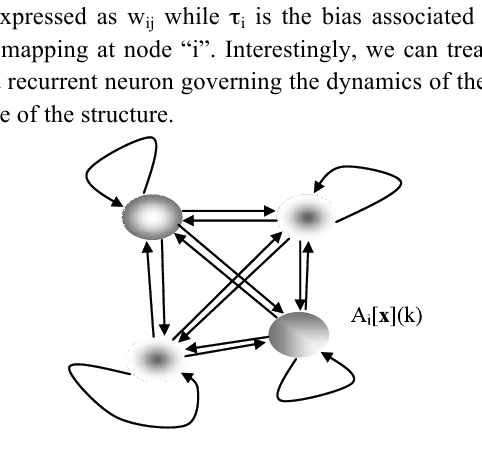
Figure 1. A web of connections between the conceptual nodes formed by the information granules and their activation levels